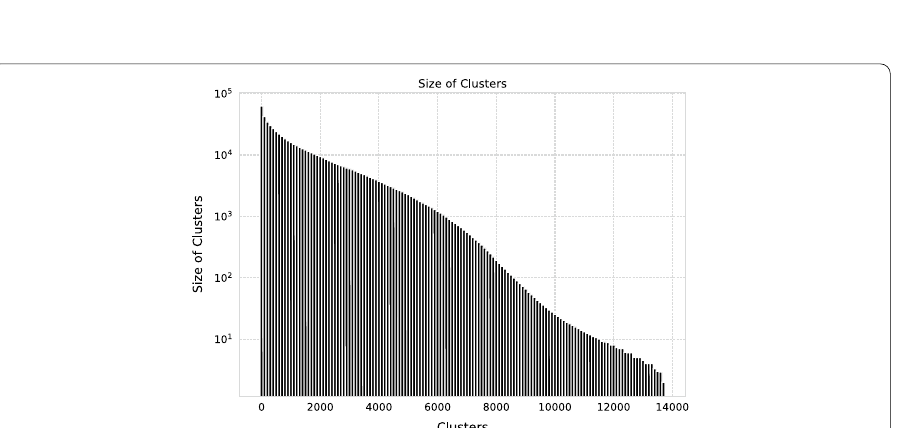
Fig. 8 Cluster size in 2020. The cluster size increases on a log scale in the use of modularity